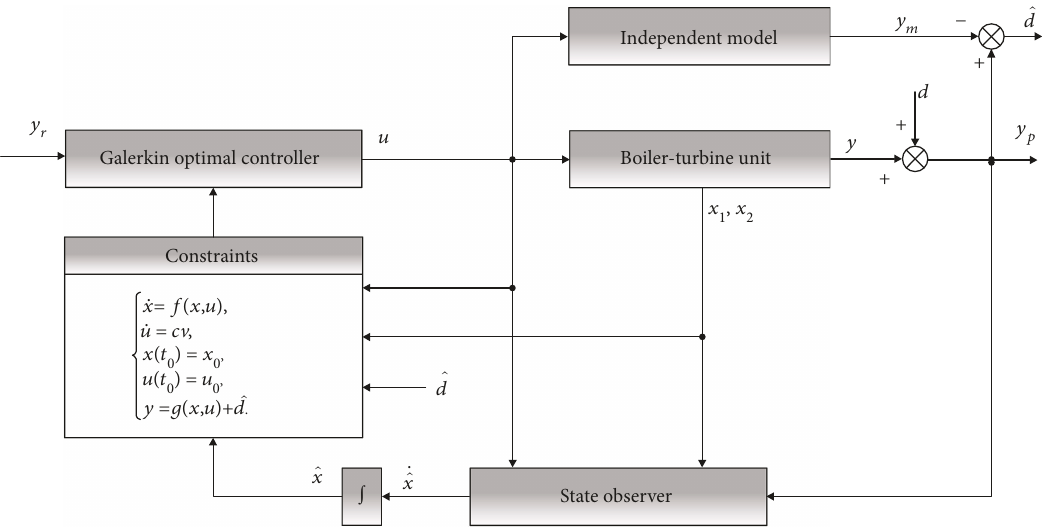
Figure 4: Block diagram used to implement the receding Galerkin method with the independent